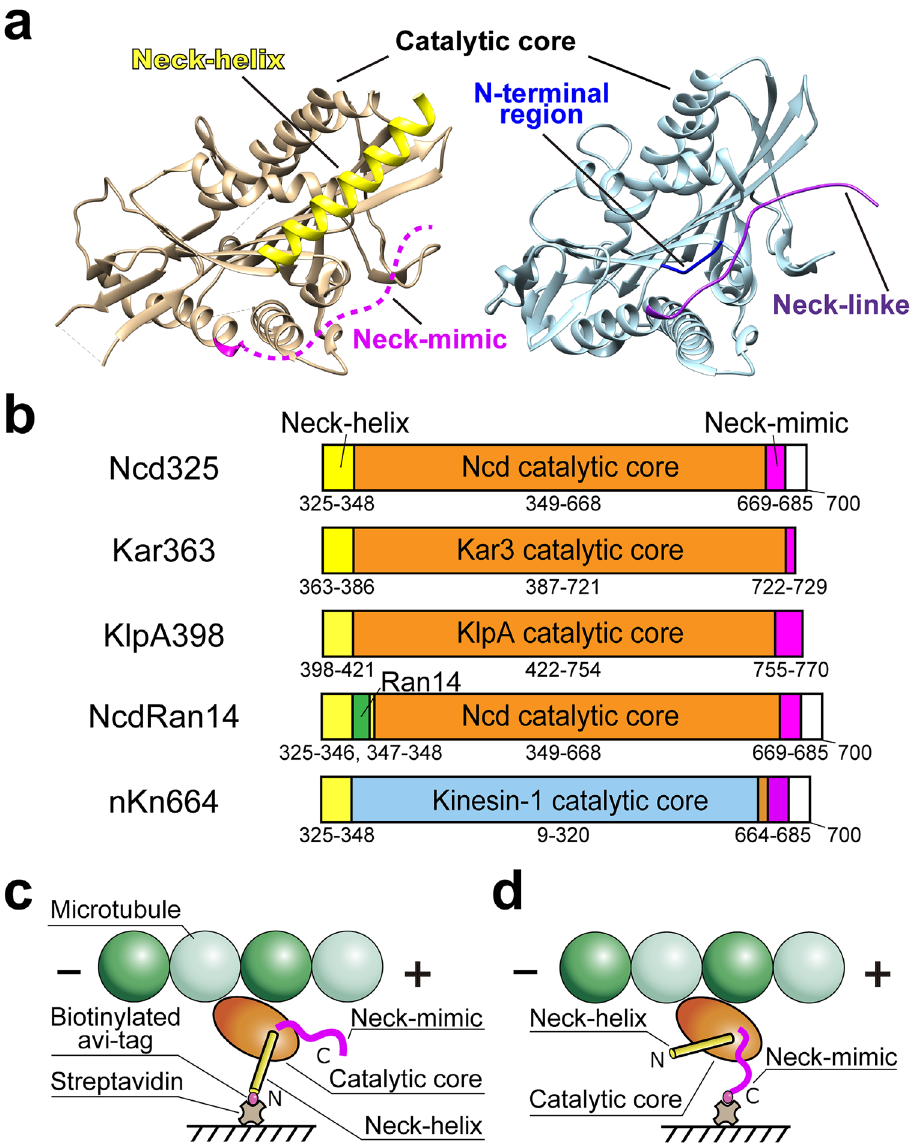
Figure 1. Observation of the directionality of N- or C-linked monomeric kinesin-14. ( a ) The 3D structure of Ncd (PDB: 5W3D) 43 and kinesin-1 (PDB: 4HNA) 44 . The catalytic core (Ncd, orange; kinesin-1, cyan) has high structural homology among kinesins. The N-terminal neck-helix of Ncd (yellow) and cover-strand of kinesin-1 (blue) have little structural homology. The C-terminal neck-mimic of Ncd (pink) and neck-linker of kinesin-1 (purple) have little structural homology. ( b ) Monomeric constructs used in this study. All constructs (kinesin- 14s, Ncd mutant, and kinesin-1—Ncd chimera) have biotinylated peptide (avi-tag) at either their N-terminus or C-terminus. NcdRan14 construct has an insertion of random 14 residues GESGAKQGEKGESG (green) between neck-helix and catalytic core, corresponding to the dimeric ncd-ran12 of the previous report 28 . nKn664 chimera is composed of Ncd K325-N348—RnKIF5C I9-K320—Ncd A664-K700 38 , corresponding to the dimeric chimera NcdKHC1 of the previous report 37 . ( c , d ) Scheme of a monomeric kinesin-14 anchored to the streptavidin-coated substrate via its N-terminus ( c ) and C-terminus ( d ),